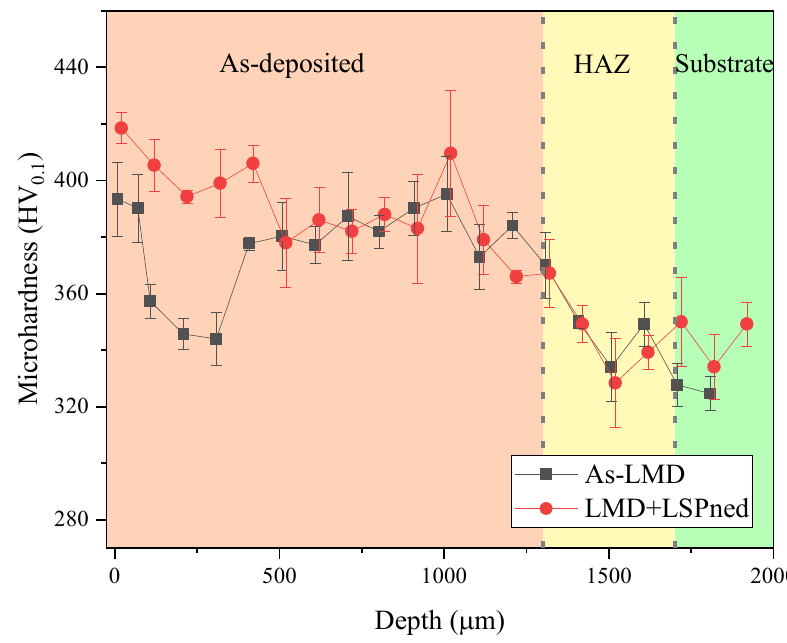
Figure 4. The cross-sectional microhardness distribution of as-LMD and LAM+LSPned samples.